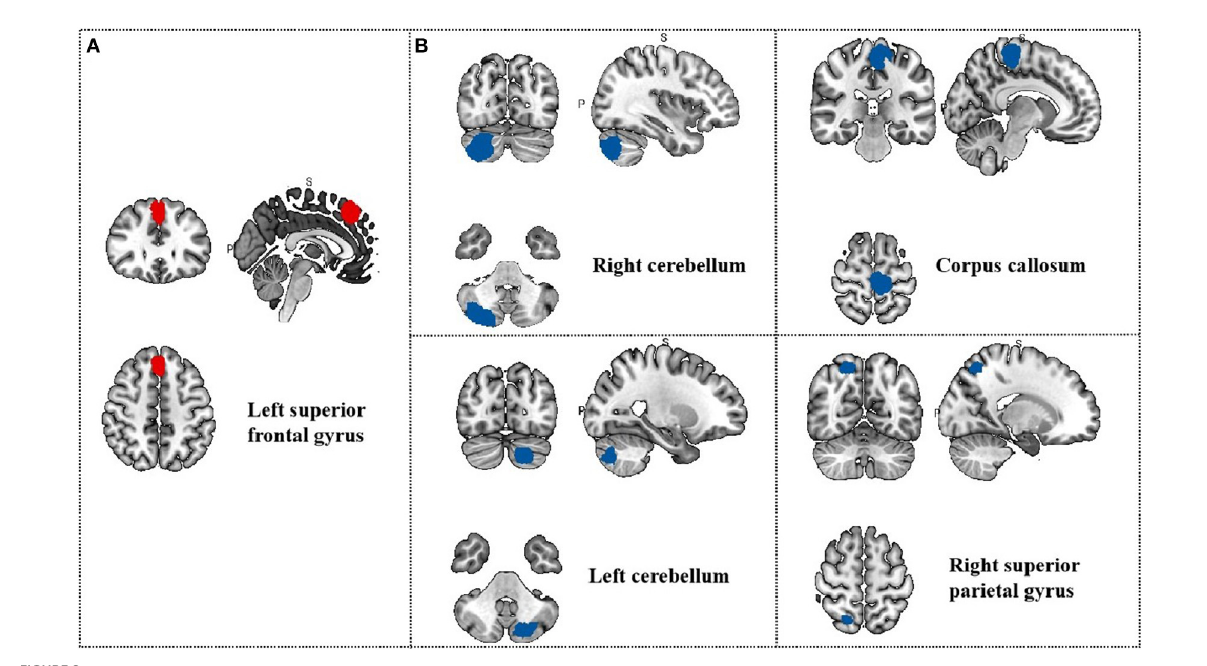
FIGURE8 Results of Meta-regression linear model analysis. (A) SAS scores of migraine patients are positive correlated with regional activity in the Left superior frontal gyrus; (B) SAS scores of migraine patients are negative correlated with regional activity in the Right cerebellum, the Left cerebellum, the Corpus callosum and the Right superior parietal